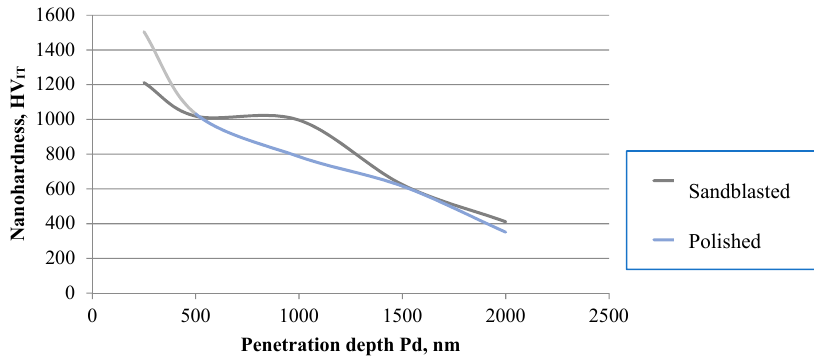
Figure 7. Depth profile of microhardness for the DLC coating applied onto the Ti-13Nb-13Zr alloy.